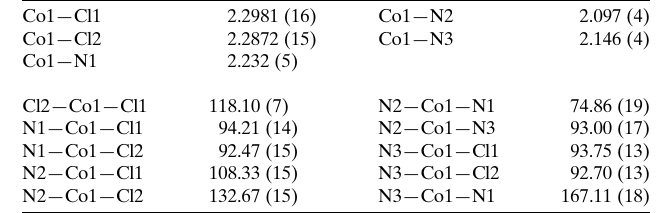
Table 4 Selected geometric parameters (A˚ , (cid:5) ) for Co(Phpz)Cl 2